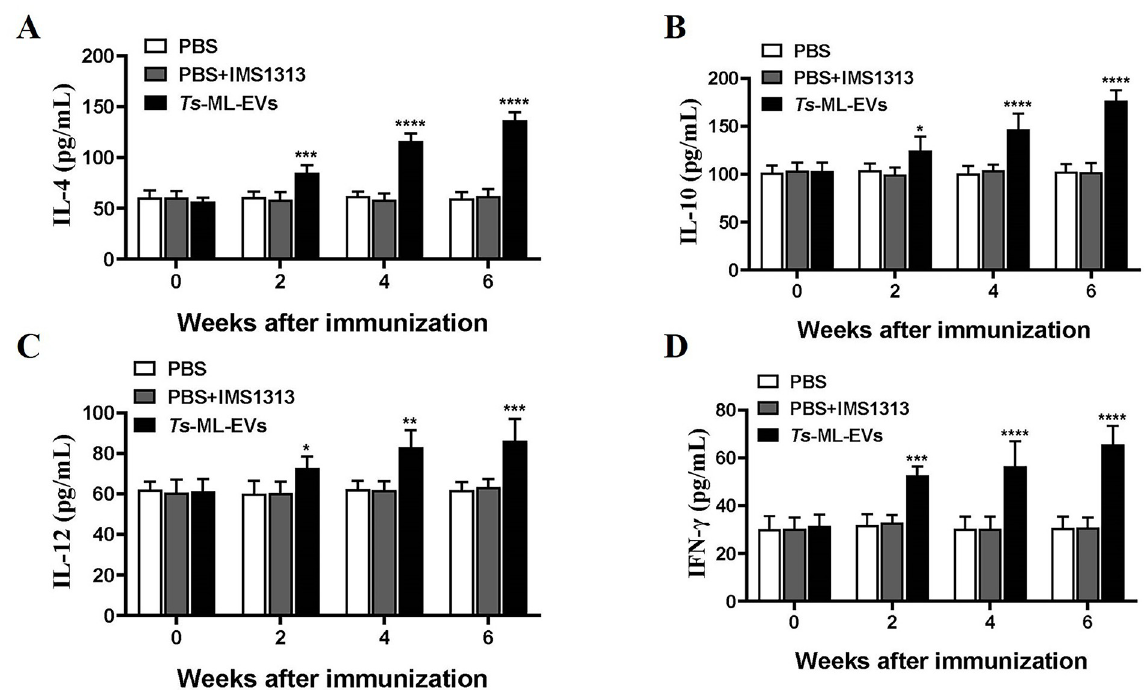
Fig 6. Vaccination results increased expression of cytokines in serum. Expression levels of IL-4 (A), IL-10 (B), IL-12 (C) and IFN- γ (D) stimulated with Ts -ML-EVs were determined by ELISA. Results represent the mean absorbance measured at 450 nm from each group. Data were evaluated by Dunnett’s multiple comparison poet hoc test. All data are pooled from three independent experiments. � P < 0.05, �� P < 0.01, ��� P < 0.001, ���� P <